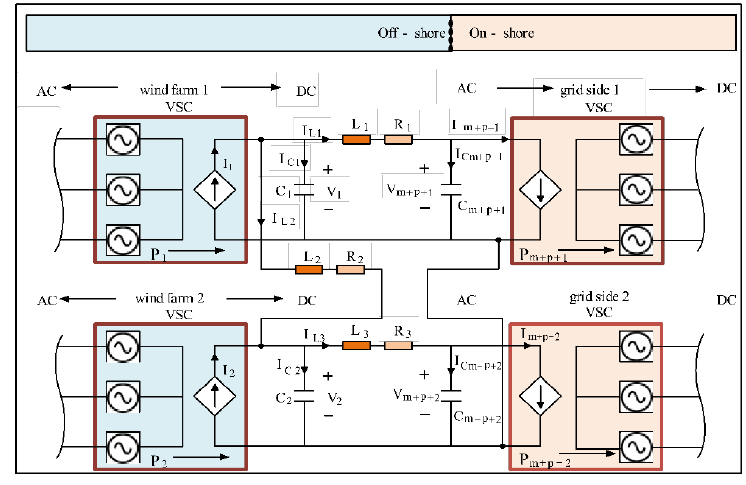
Figure 3. Four terminal VSC-based MTDC grid .